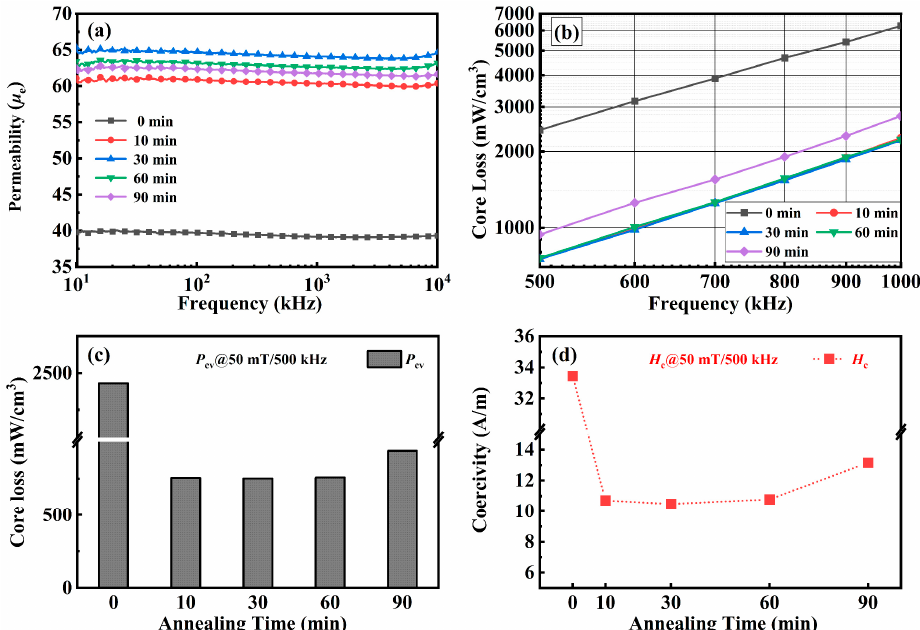
Figure 5. ( a ) μ e , ( b ) P cv , ( c ) histogram of P cv , and ( d ) H c change curve of Fe 74.75 Si 8 B 10 P 3 C 2 Nb 1.5 Cu 0.75 NPCs annealed for different HT .